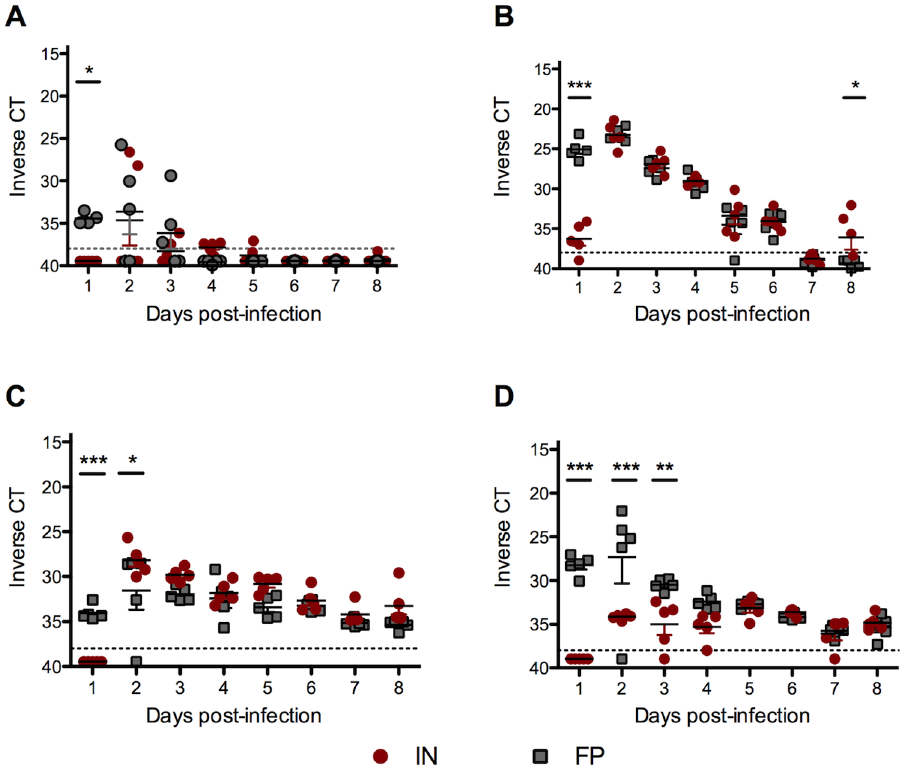
Figure 3. FP-inoculated mice successfully cleared D NSs virus despite high virus RNA levels at early timepoints. Viral RNA loads in (A) blood, (B) liver, (C) spleen and (D) draining popliteal lymph node. Averages based on 5 mice per group per time